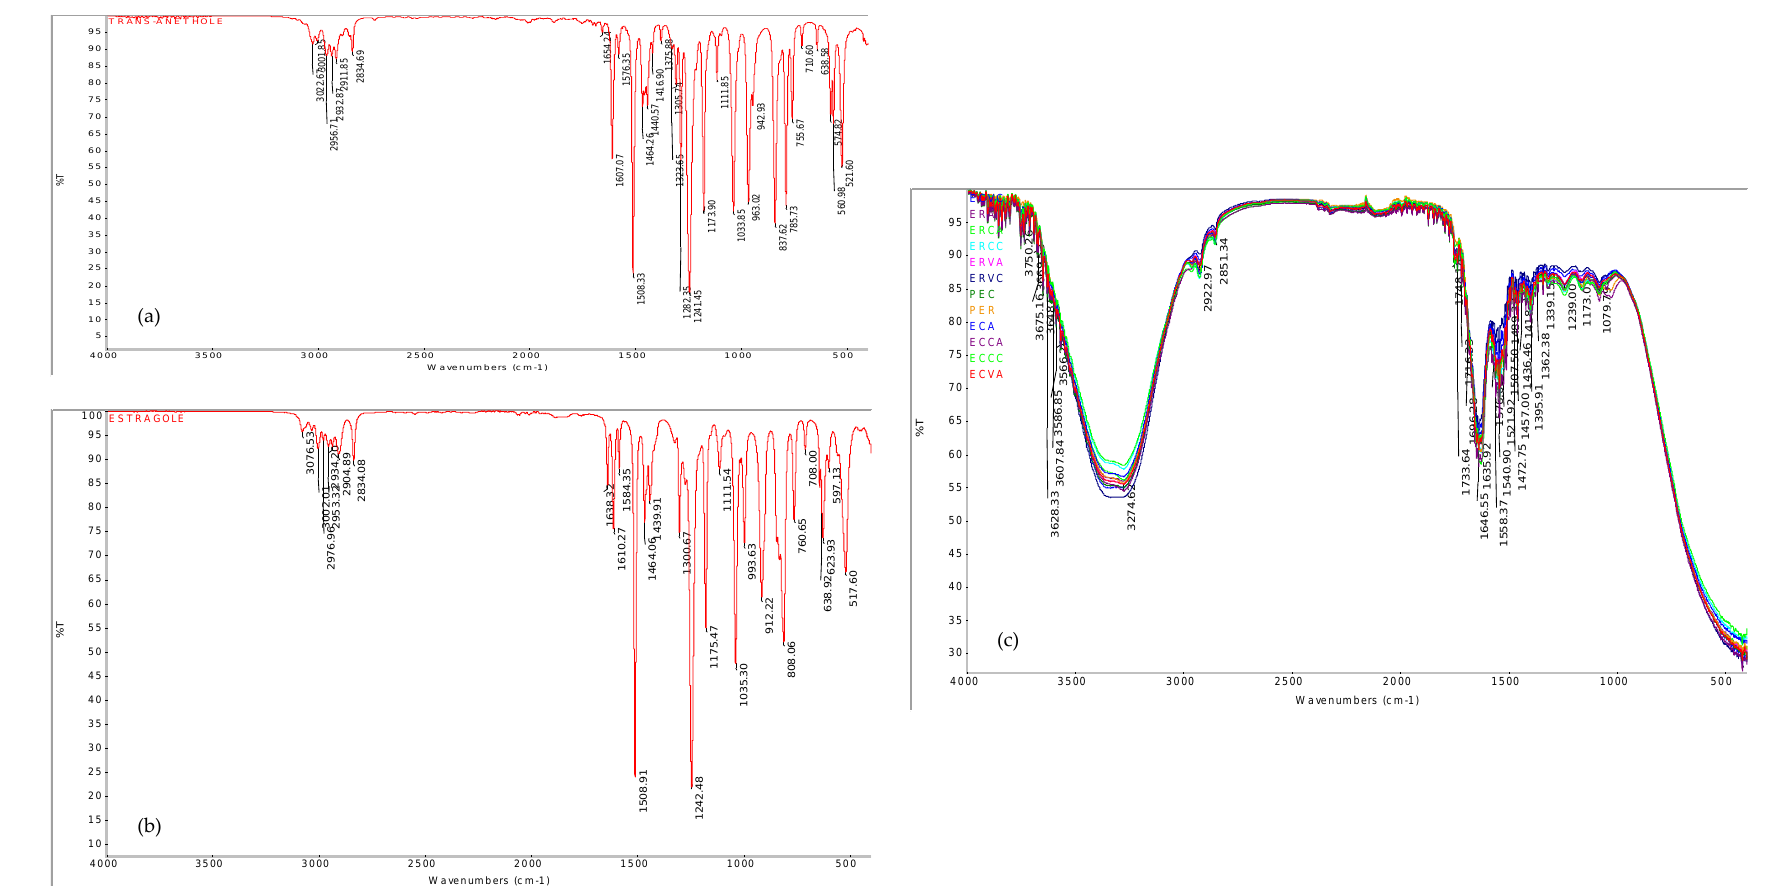
Figure 1. Fourier-transform infrared spectroscopy spectra of ( a ) standard trans-anethole, ( b ) standard estragole, ( c ) meatballs with the addition of aqueous extract of lemon balm/wild thymes; ECPC and ECPA are pork meatballs enriched with wild thyme aqueous extract, processed by hot air and steam convection; ERPC and ERPA are pork meatballs enriched with lemon balm aqueous extract, processed by hot air and steam convection; ERCC and ERCA are turkey meatballs enriched with lemon balm aqueous extract, processed by hot air and steam convection; ECVC and ECVA are beef meatballs enriched with wild thyme aqueous extract, processed by hot air and steam convection; ERVC and ERVA are beef meatballs enriched with lemon balm aqueous extract, processed by hot air and steam convection.